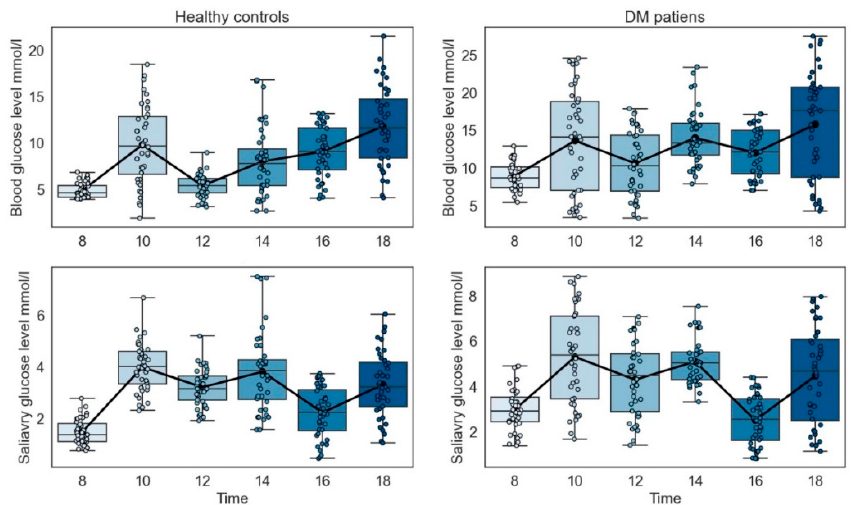
Figure 2. Changes in salivary glucose levels of participants at different collection times.